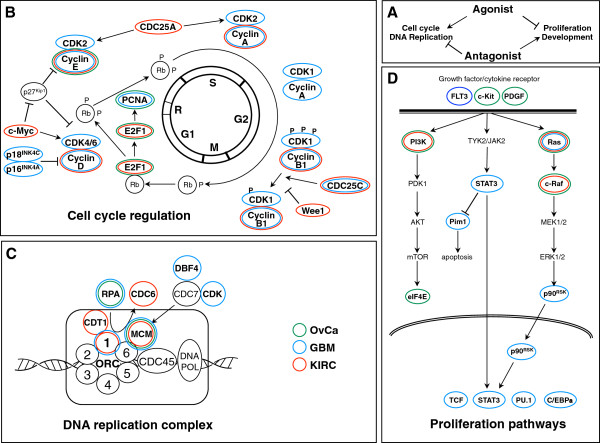
Cancer relevant signaling pathways that the agonistic and antagonistic miRNAs may regulate in human cancers. The lists of genes that positively correlate with either the agonistic or the antagonistic miRNAs (Additional file 11: Table S10) were subjected to an IPA analysis. (A) Genes that inversely correlated with agonists and antagonists fell into four classes, cell cycle regulation, DNA replication, proliferation, and development. (B, C) Genes related to cell cycle regulation (B) and DNA replication (C) whose expression was positively correlated with the agonistic miRNAs and negatively correlated with the antagonistic miRNAs. (D) Genes linked to proliferation whose expression was positively correlated with the antagonistic miRNAs and negatively correlated with the agonistic miRNAs. (B, C, D) The three different colors indicate the three different cancers: green, OvCa; blue, GBM; red, KIRC.